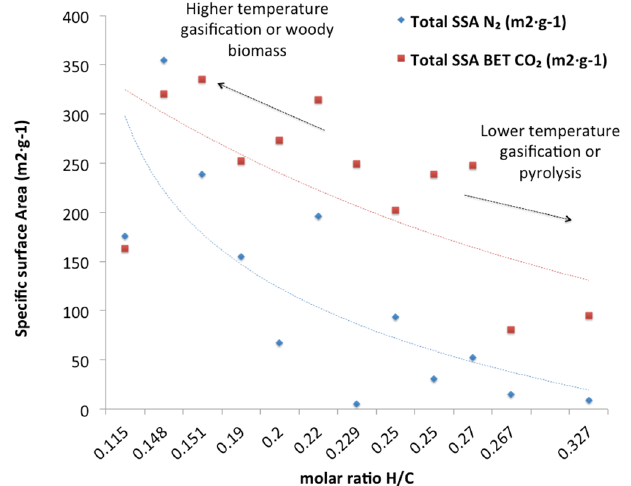
Figure 13. Specific surface area (m 2 · g − 1 ), estimated by N 2 and CO 2 adsorption, as a function of the degree of carbonization (ratio